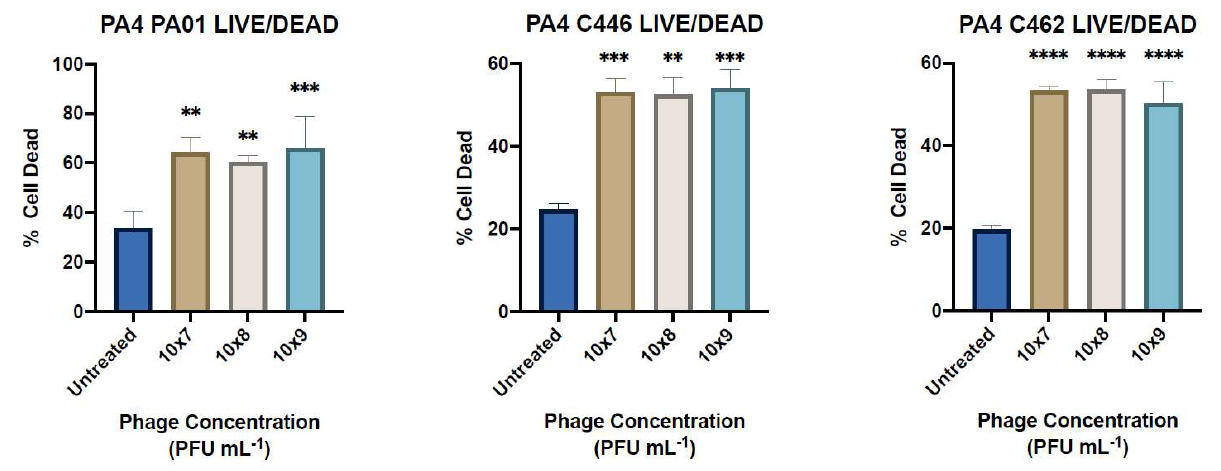
Figure 5. LIVE/DEAD Assays. Percentage of cells dead in biofilms treated with PA4 at three different concentrations (1 × 10 7 , 1 × 10 8 , 1 × 10 9 PFU mL −1 ) with significance determined compared to the untreated control. Data expressed as mean ± SEM for three independent experiments. **, p < 0.01; ***, p < 0.001; ****, p < 0.0001.